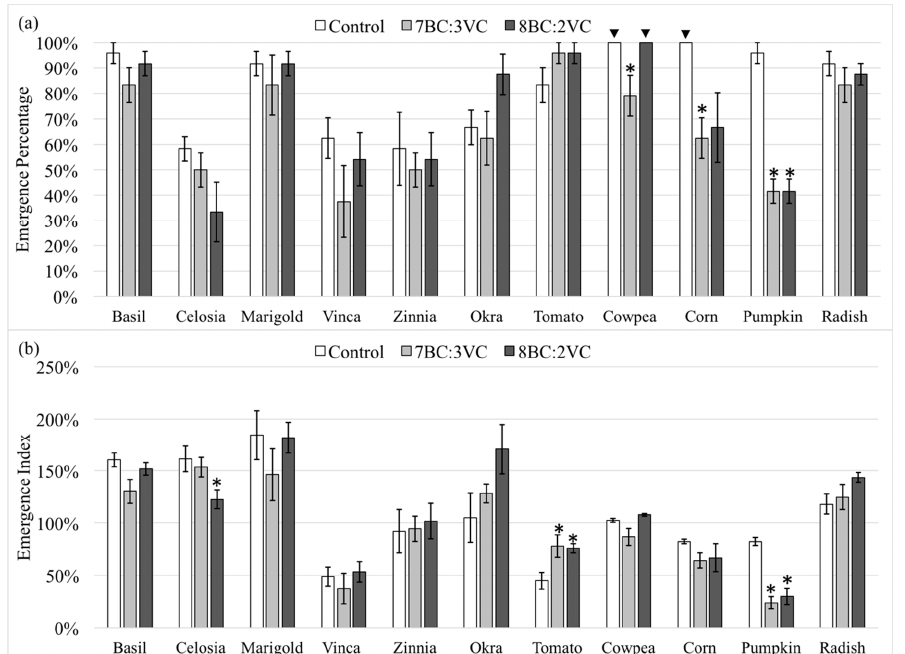
Figure 1. Seeds’ emergence percentages ( a ) and emergence indexes ( b ) (mean ± standard error) in commercial propagation mix (control), 70% biochar:30% vermicompost (7BC:3VC, by volume), or 8BC:2VC in Experiment 1. The asterisks (*) indicate differences from the control using Dunnett’s test at p < 0.05 ( n = 4). Means indicated by “(cid:31)” are 100% ± 0.